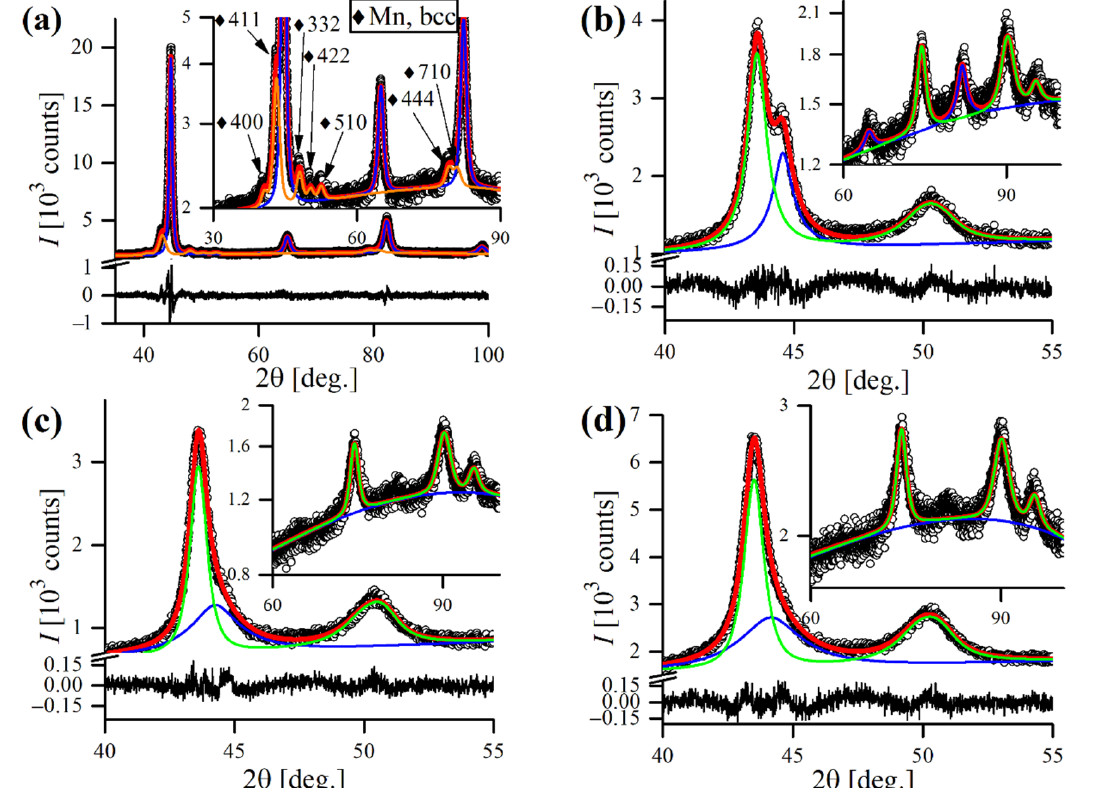
Figure 8. WPPM-refined experimental patterns gathered after: ( a ) 5 h of MA, ( b ) 30 h of MA, ( c ) 60 h of MA, ( d ) 150 h of MA. Legend: hollow dot—experimental data, red line—WPPM model, orange line—Mn-bcc phase, blue line—Fe-bcc phase, green line—Fe-fcc phase, black line—residual.